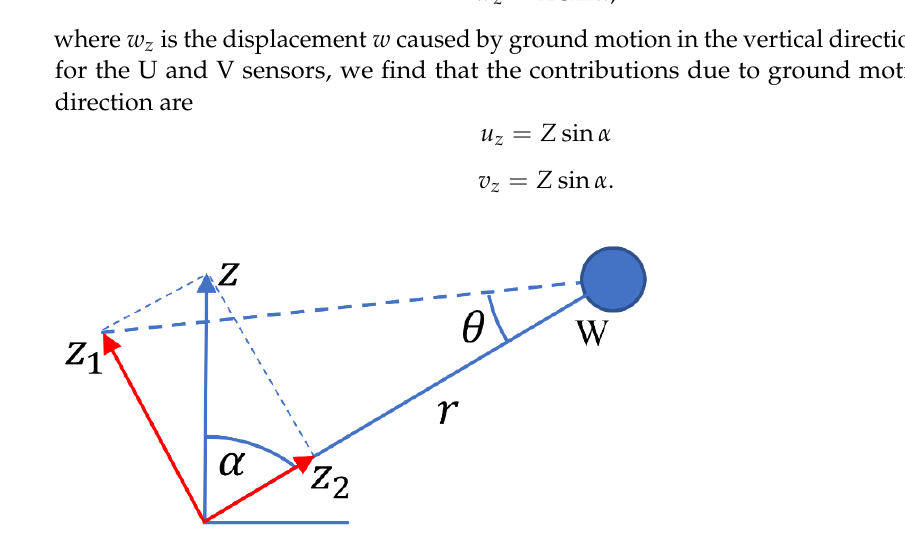
Figure 2. The W component seismometer is in its plane of motion, with the ground, drawn as a horizontal line, moving upward by a displacement of 𝑧 .